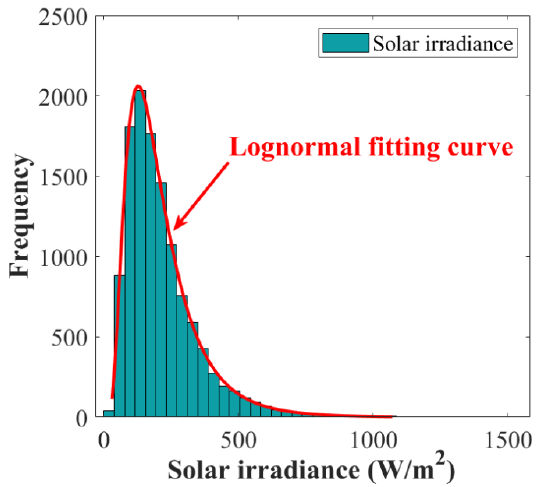
Figure 1. The distribution of solar irradiance.